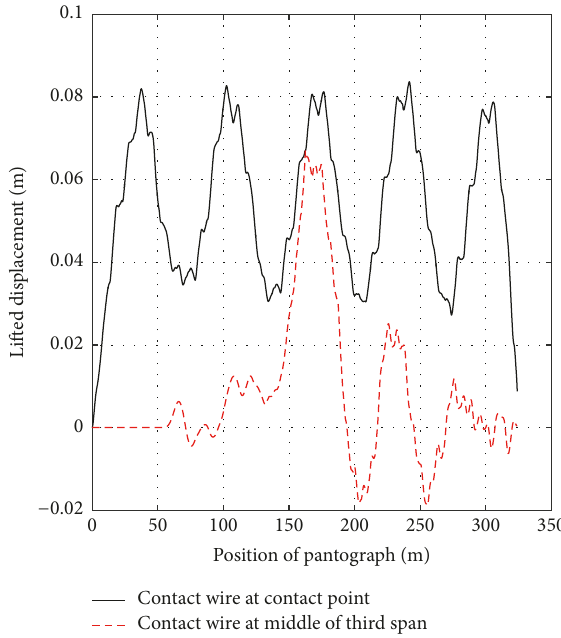
Figure 15: Lifted displacements of the contact wire at a speed of 160 km/h. Solid line: at the contact point. Dashed line: in the middle of the third